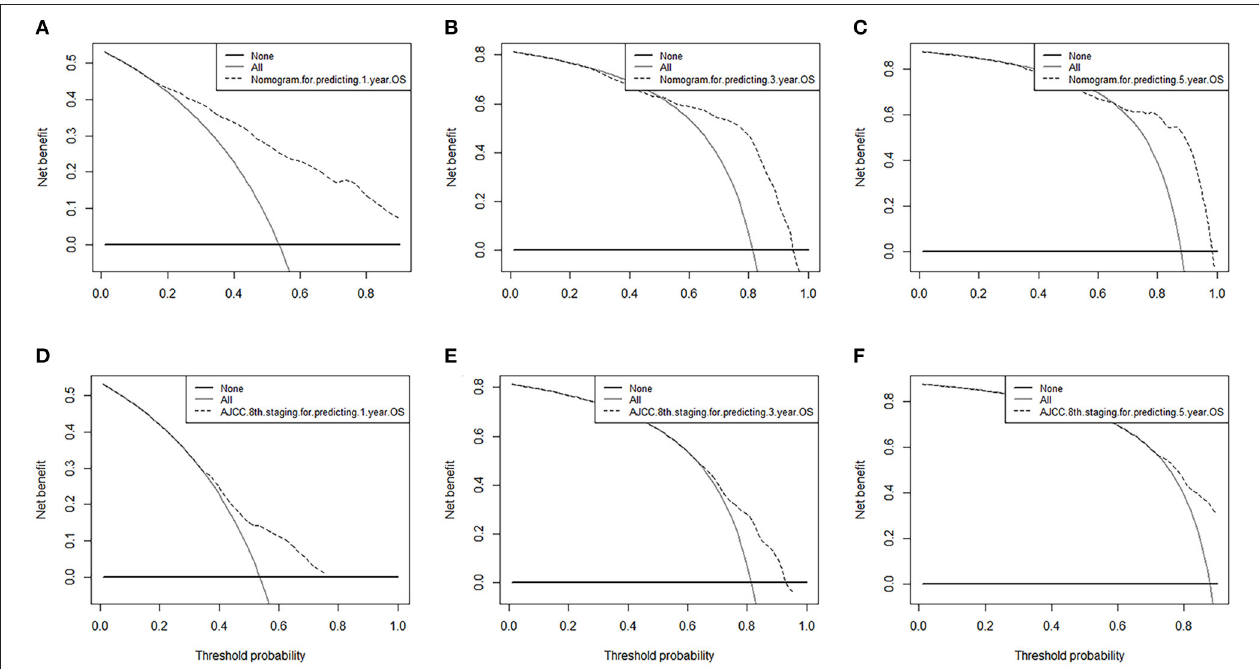
FIGURE 6 | Decision curve analysis of nomograms and AJCC 8th edition staging system for predicting (A,D) 1-year OS; (B,E) 3-year OS; (C,F) 5-year